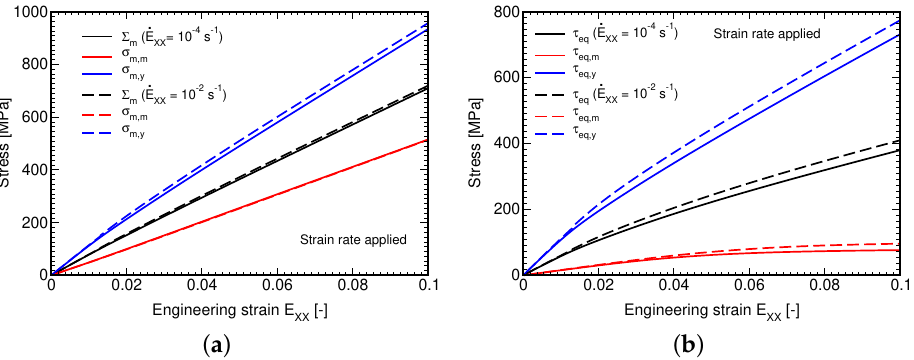
Figure 16. Plain weave composite loaded in tension by prescribed macroscopic strain rates ˙ E = 10 − 2 s − 1 and ˙ E = 10 − 4 s − 1 : ( a ) mean stress, ( b ) equivalent deviatoric XX XX